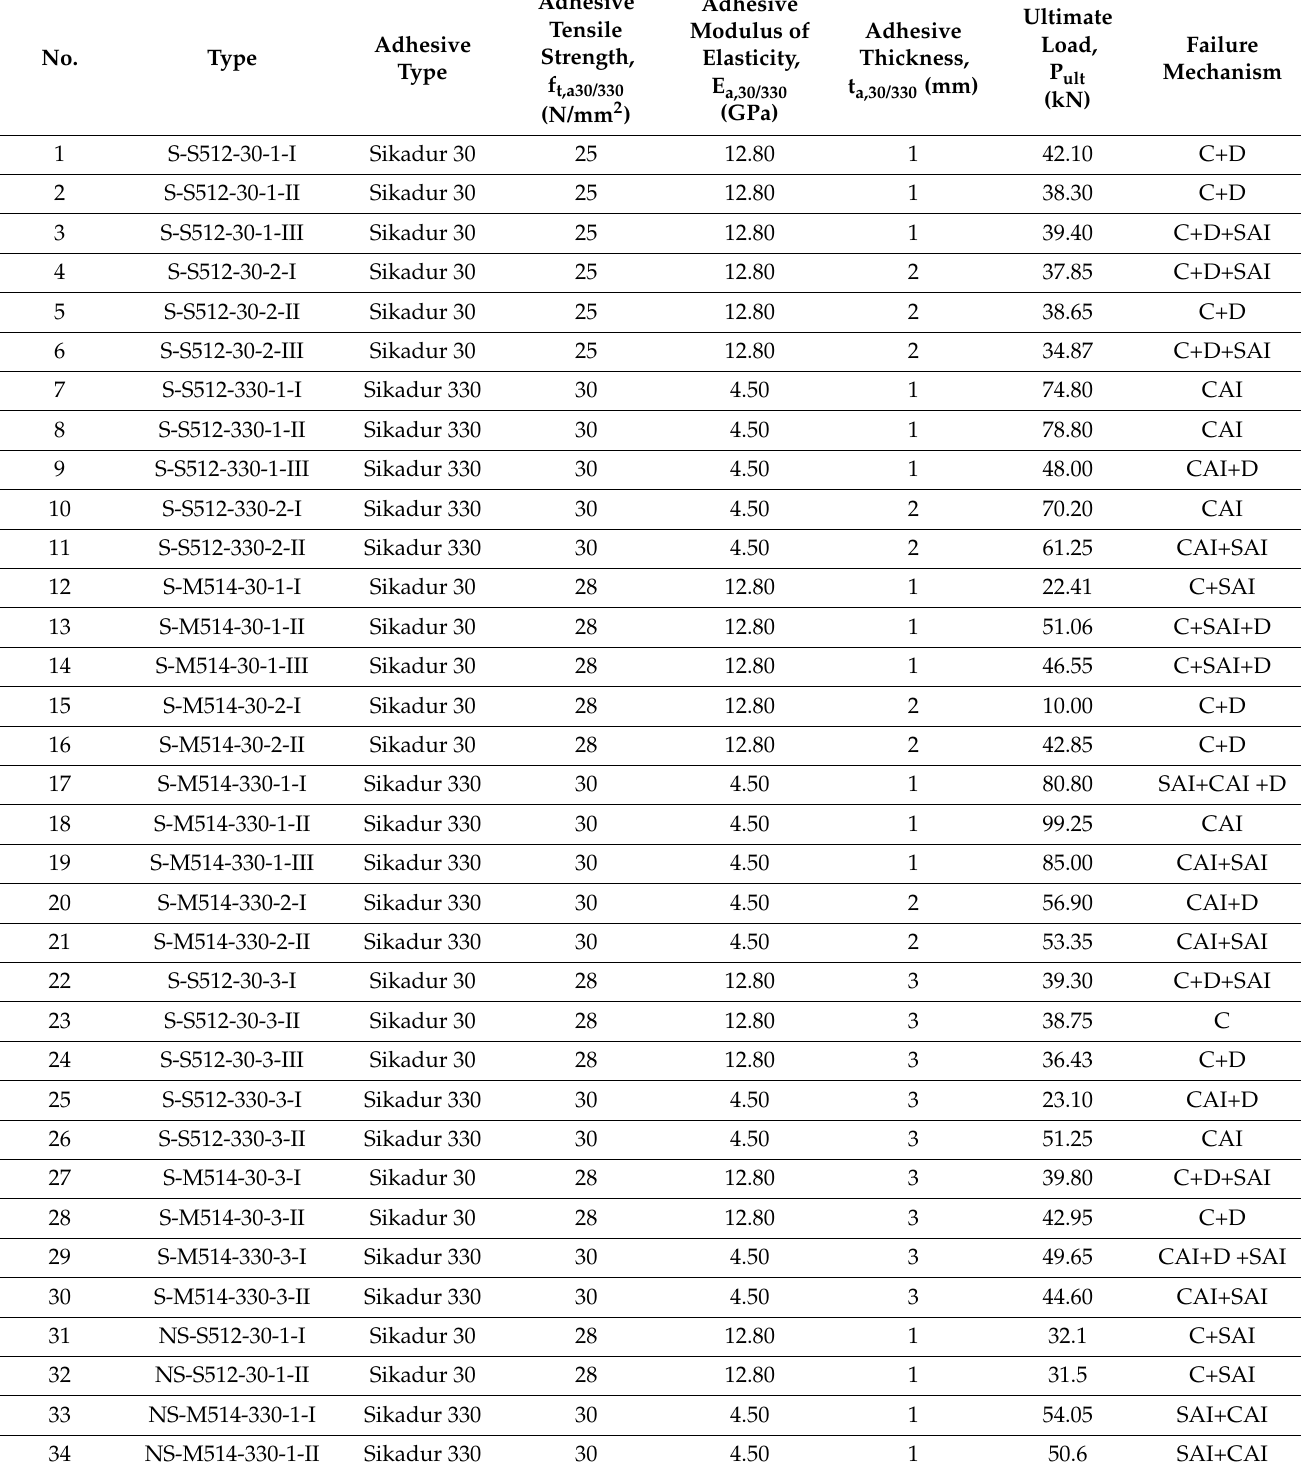
Table 5. Specimen details, ultimate loads and failure